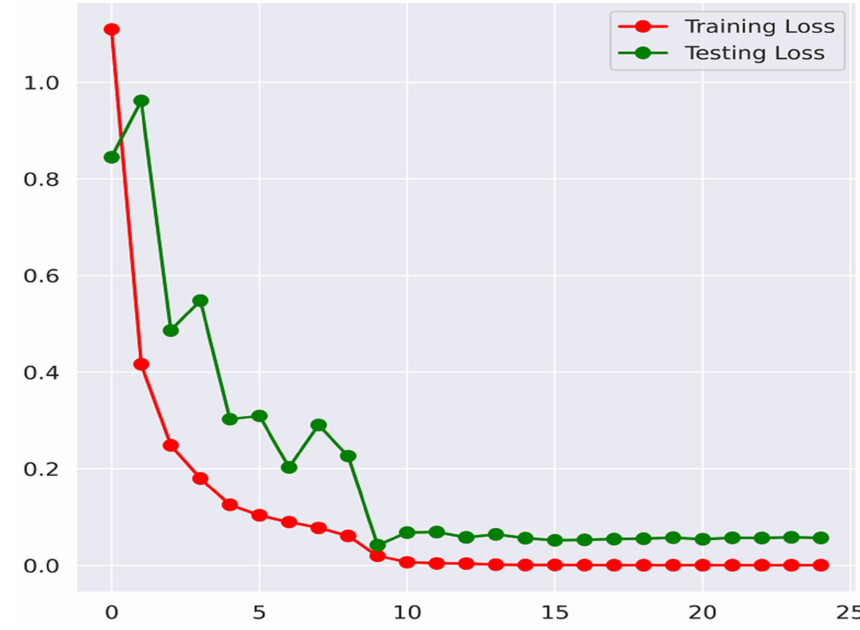
Figure 5. Training and testing losses for